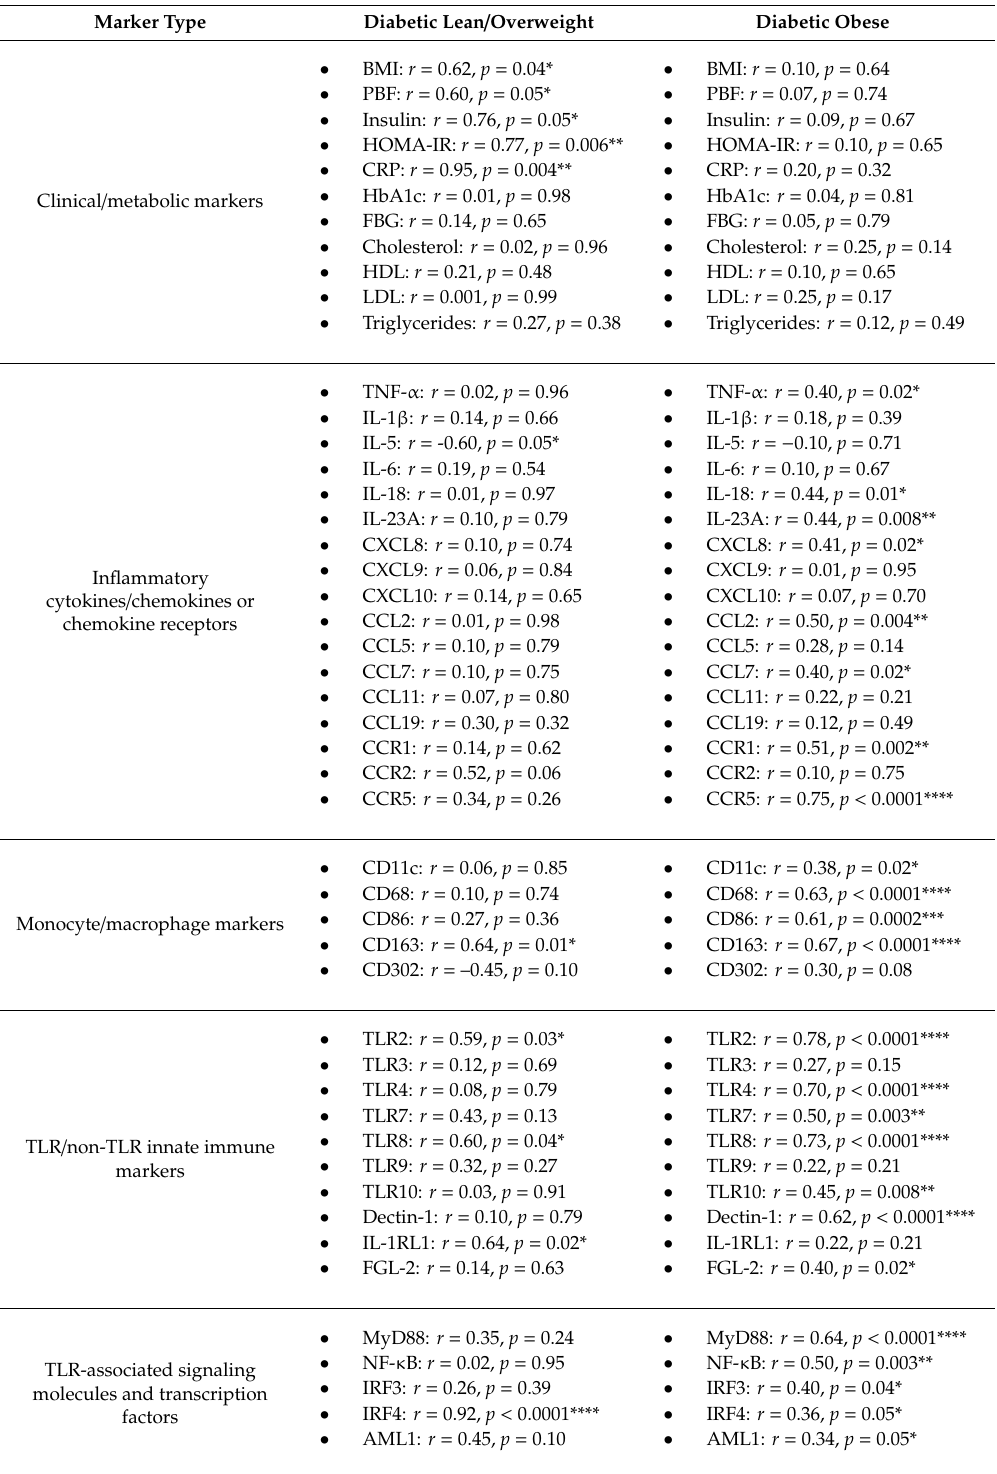
Table 2. Correlation of the adipose IRF5 gene expression with various